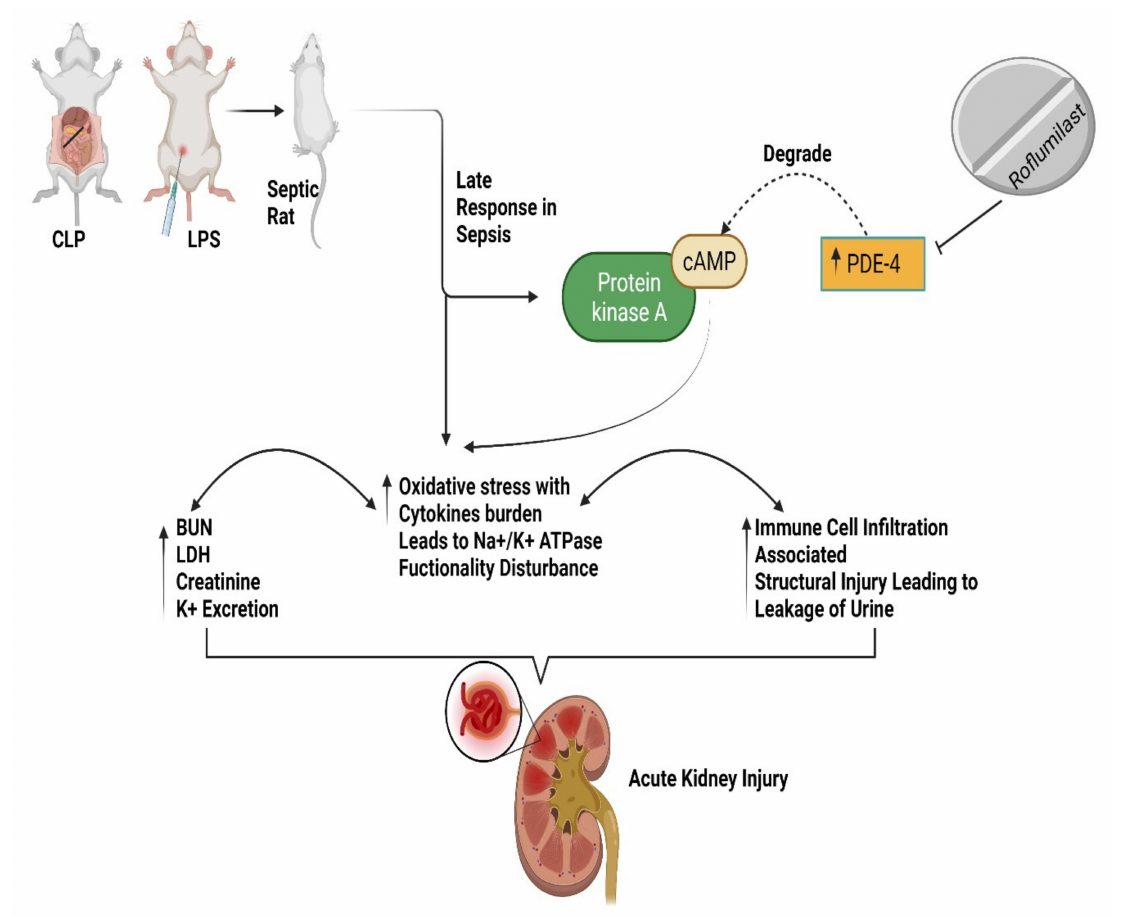
Figure 3. Represents septic rats with PDE-4 inhibition leading to increased cAMP levels, alleviat- ing renal impairment, oxidative and inflammatory stress, and decreasing immune cell infiltration and leakage in urine [15]. BUN, Blood urea nitrogen; cAMP, cyclic adenosine monophosphate; cecal ligation and puncture (CLP), LDH, lactate dehydrogenase; lipopolysaccharide (LPS); PDE-4,